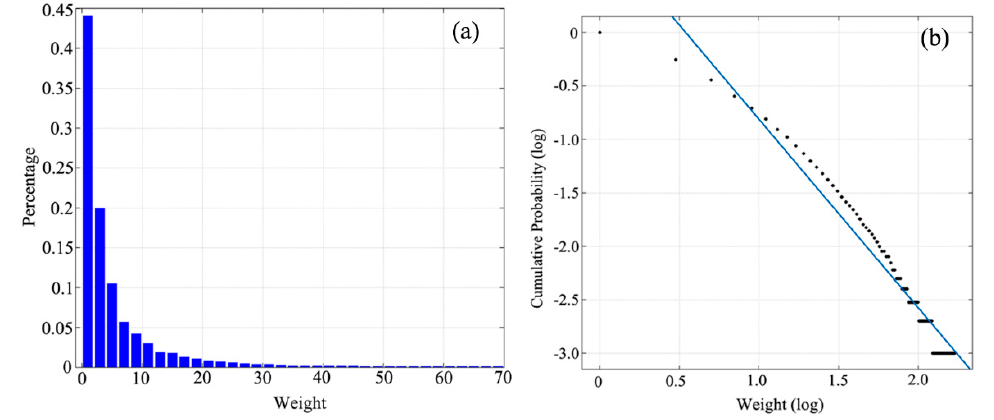
Figure 8. Statistical distribution of the weight of edges.